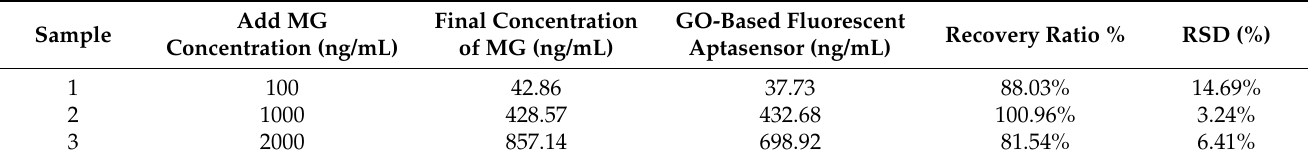
Figure 5. GO concentration optimization and sensitivity test of aptamer MG-36-17 in GO-based fluorescent aptasensor. ( a ) GO concentration for the fluorescence quenching of FAM-labeled aptamer MG-36-17. ( b ) The relative fluorescence intensity of FAM aptamer after incubation with a series of concentrations of MG (0 – 8571.43 ng/mL). The inset shows a good linear response from 1.71 to 857.14 ng/mL of MG (R 2 = 0.9926). Error bars were obtained from three parallel experiments. Table 3. Detection of MG in 5-fold diluted actual water from the aquatic product market using fitted curve in Figure S4b was revised to 0.0015. aptamer MG-36-17 in GO-based fluorescent